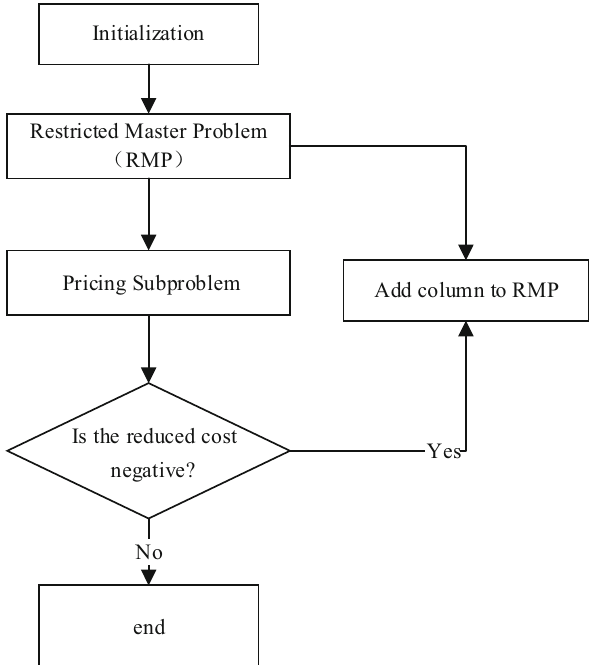
Fig. 6 Column generation framework for finding multi-vehicle